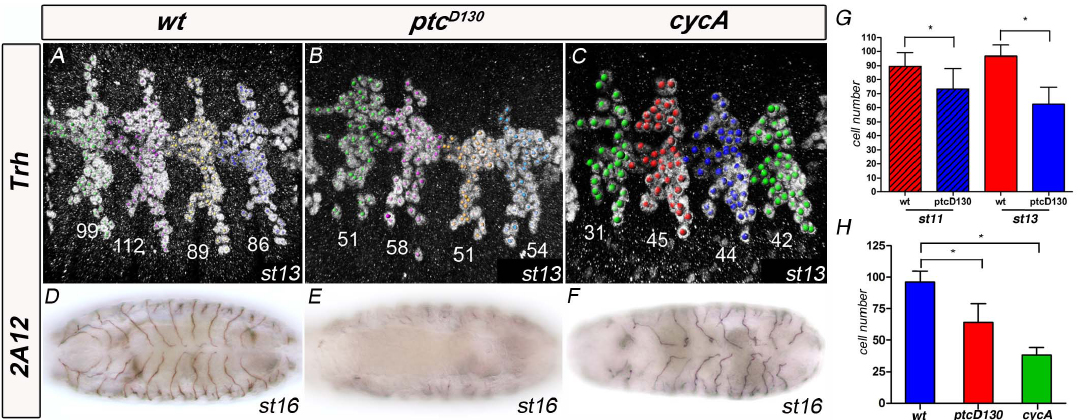
Figure 2. ptc mutants have fewer tracheal cells than wild-type. (A–C) Lateral views of Tr4-Tr7 of stage 13 wt (A), ptc mutant (B) and cycA mutant (C) embryos stained with anti-Trh antibody to visualise the tracheal nuclei. Nuclei were marked and counted using the Imaris software and the numbers in each metamere correspond to the number of nuclei marked. Anterior is left. (D–F) Ventral views of stage 16 wt (D), ptc mutant (E) and cycA mutant (F) whole-mount embryos stained with 2A12 antibody to visualise the tracheal lumen. GBs are present and enter the VNC in cycA mutant embryos, despite the very low numbers of tracheal cells. Anterior is left. (G,H) Quantification of tracheal cell numbers in wt, ptc and cycA embryos. (G) Comparison of cell numbers in Tr5 of wt and ptc mutant at stages 11 and 13; Tr5 at stage 11 have an average of 90 cells in the wt (n=16) and 73 cells in ptc embryos (n=18); Tr5 at stage 13 have an average of 97 cells in the wt (n=11) and 63 cells in ptc embryos (n=19). (H) Comparison of cell numbers in Tr5 of wt , ptc and cycA mutants at stage13; Tr5 at stage 11 have an average of 97 cells in the wt (n=11), 63 cells in ptc embryos (n=19) and 38 cells in cycA mutants (n=8). *P-value # 0.01.